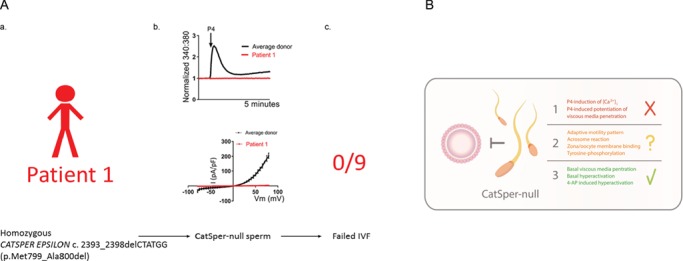

Observations from studies of CatSper-null human sperm.
A. A diagrammatic summary of our findings from the study of patient 1 in Brown et al. (2018). (a) A microdeletion in exon 18 of the CatSper auxiliary subunit epsilon gene (CATSPER EPSILON) is associated with loss of CatSper function in sperm, which results in infertility. Patient 1 is homozygous for a 6-base pair in frame deletion in exon 18 of CATSPER EPSILON, which results in a loss of Methionine799 and Alanine800 in the putative extracellular domain of CATSPER EPSILON protein. This results in production of ICatSper-null sperm, which do not have any overt signs of sperm dysfunction (sperm concentration and motility were normal). (b) P4 fails to elicit an increase in [Ca2+]i (upper panel) in cell populations and ICatSper was confirmed to be absent by electrophysiology (lower panel). Data are those presented previously (Williams et al., 2015). (c) The consequence of loss of CatSper function is failed fertilization (0 out of 9 eggs inseminated) at IVF. B. Questions and answers regarding human sperm function that lack functional CatSper. ICatSper-null human sperm cannot fertilize at IVF. From our study (using cells from the same sperm population that failed IVF), we demonstrate that P4 could not induce an increase in [Ca2+]i or increase penetration into viscous media above basal levels (red). The number of cells exhibiting hyperactivation was within a normal range and could be boosted by treatment with 4-aminopyridine (4-AP). Molecular and cellular impairment that may arise due to CatSper dysfunction may include abnormal tyr/ser/thr-phosphorylation, deficiency of adaptive motility patterns, loss of zona/egg binding and failure of the acrosome reaction (amber), as suggested by Luo et al. (2019).